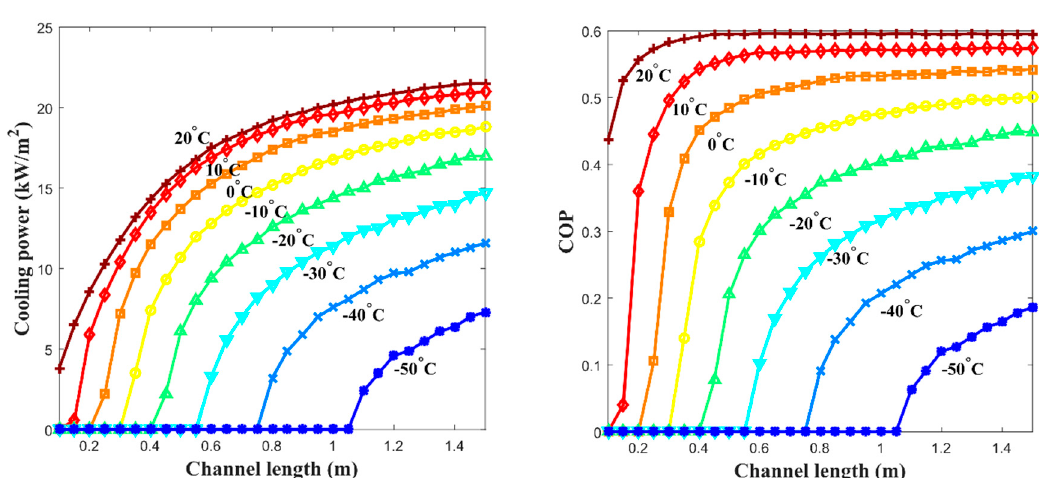
Figure 8. Performance of the proposed metal hydride thermal conversion system is shown based on the effect of channel length: ( left ) the COP cool at various channel lengths; and ( right ) the specific cooling power at various channel lengths. Both plots directly indicate that channel length affects the performance of the system.